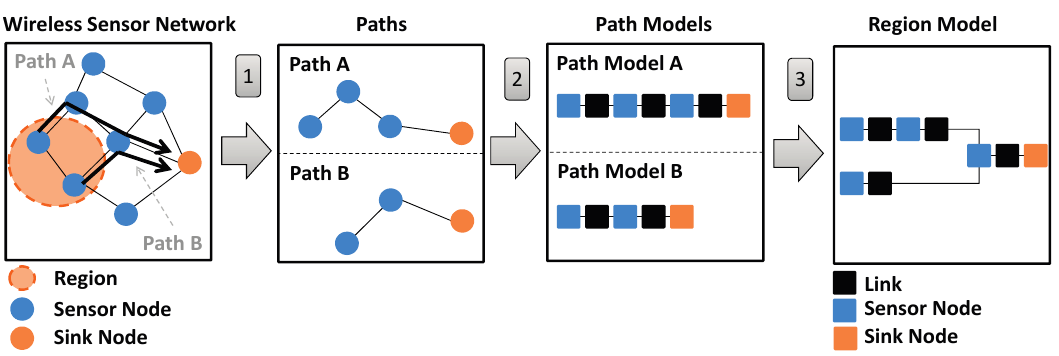
Figure 6. Overview of creating the Region Model.